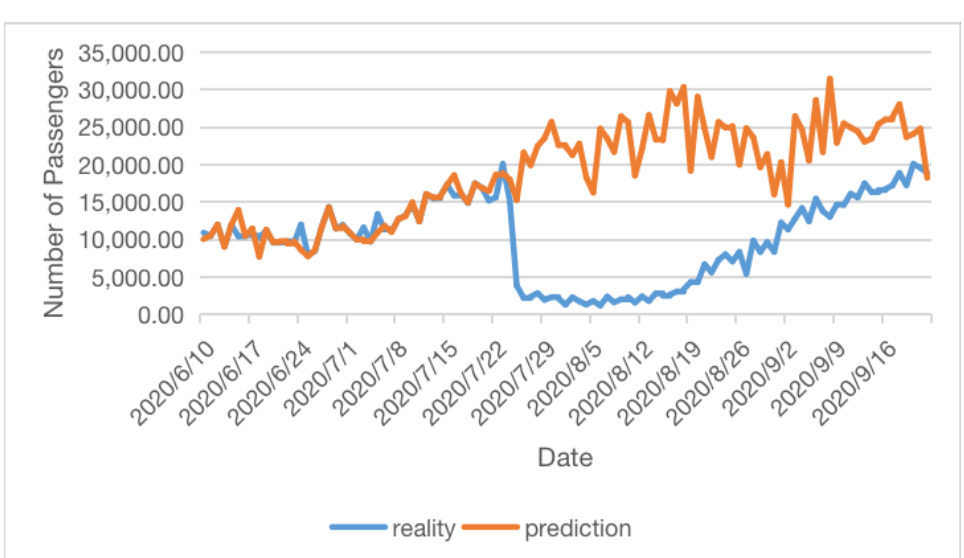
Figure 8. Dalian air passenger changing trend (LightGBM).